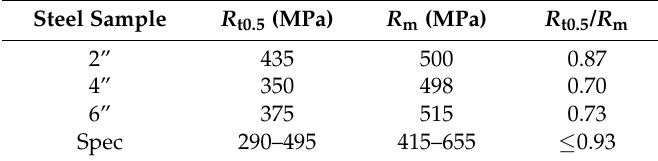
Table 2. Tensile results of collected steel pipes and acceptance criteria for PSL 2 X42 pipe.